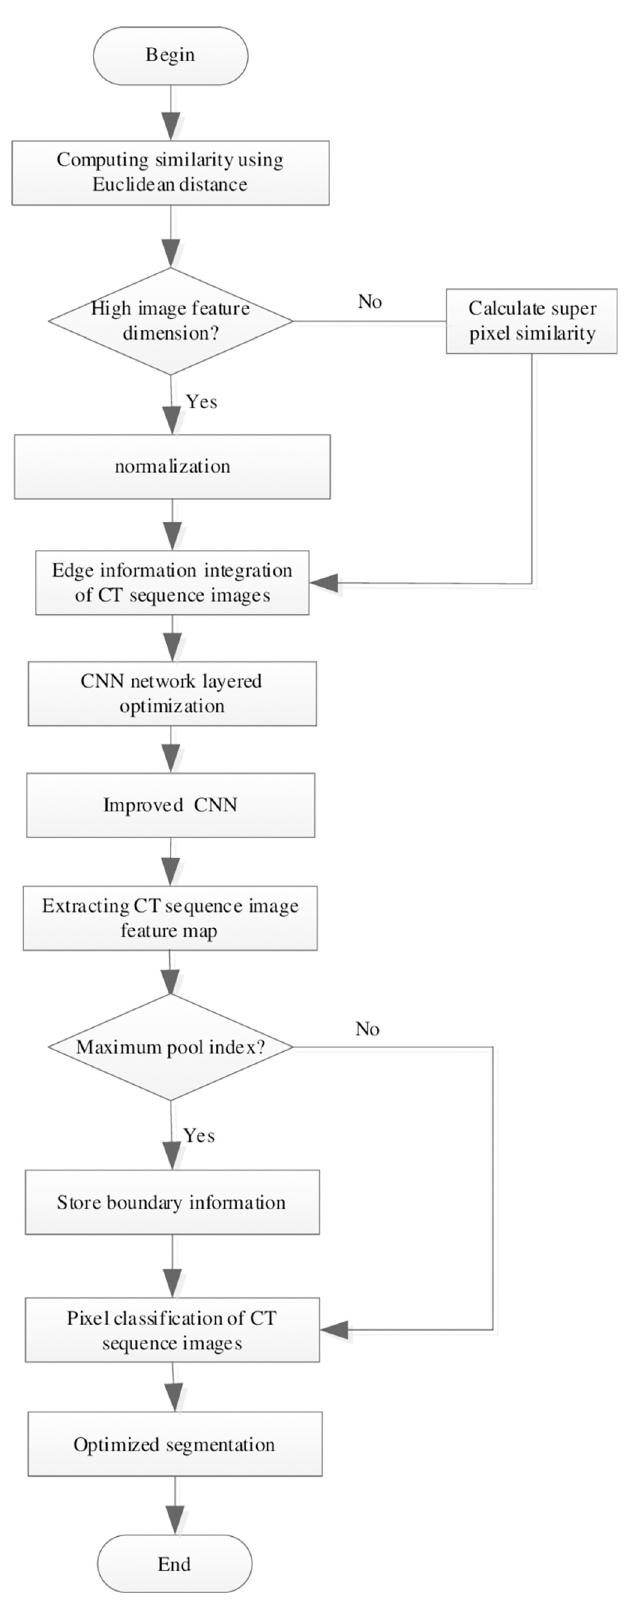
Fig 2. Edge optimization segmentation process of computed tomography sequence